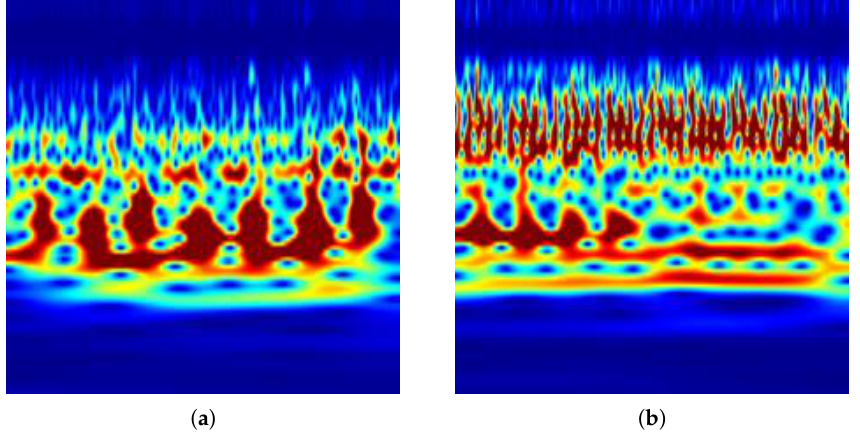
Figure 5. Typical scalogram signal: ( a ) HC and ( b ) HPT